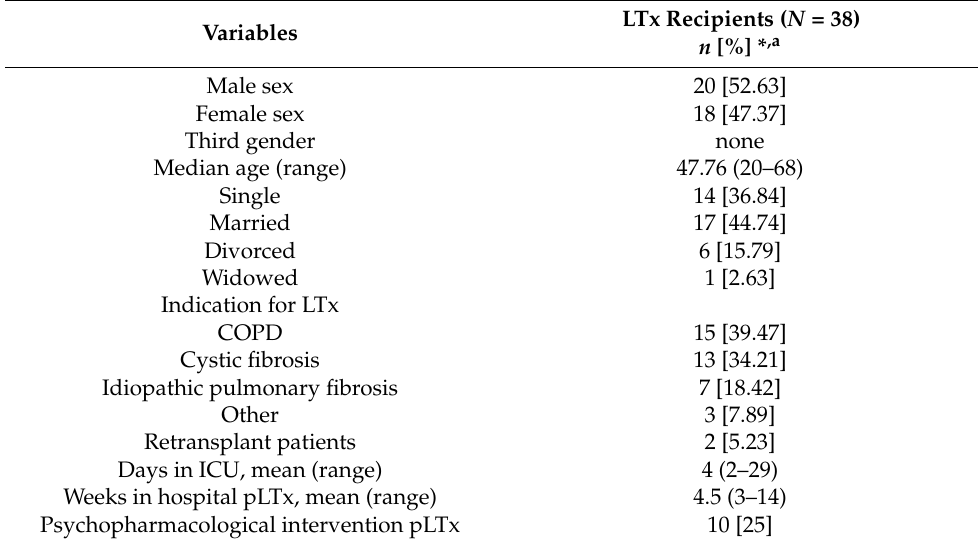
Table 1. Demographic and medical data of lung transplantation